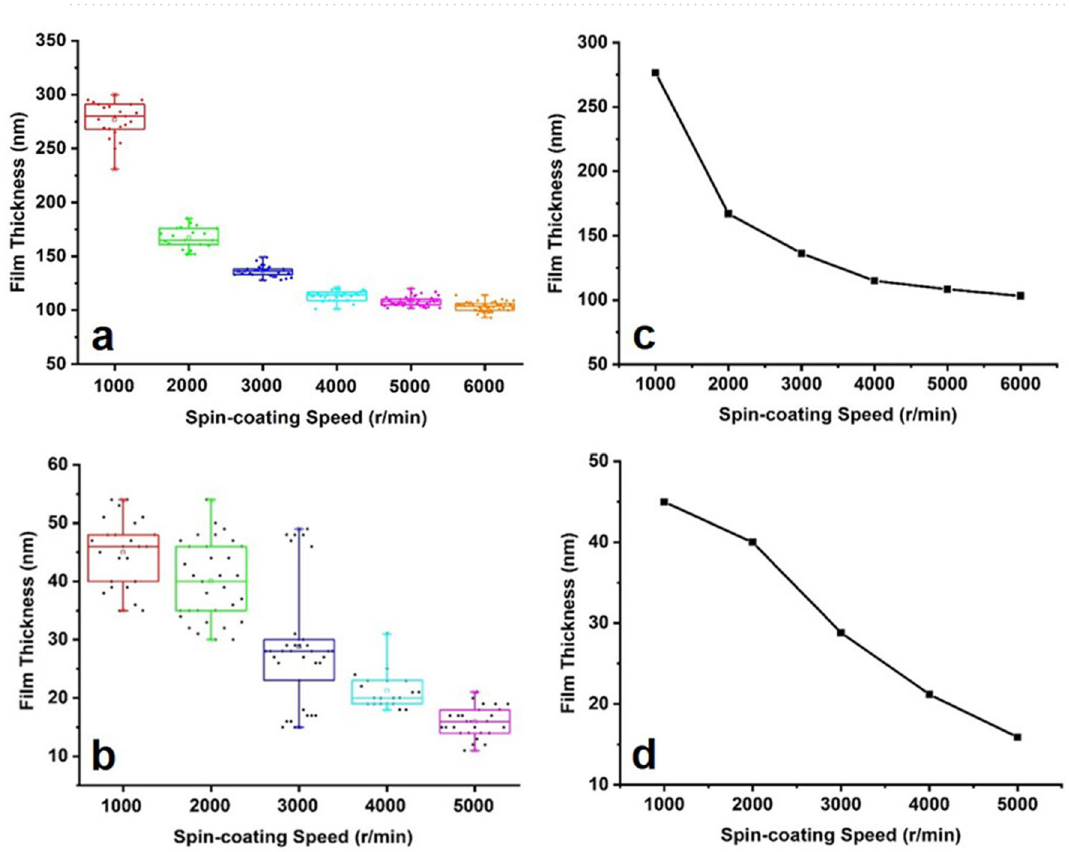
Figure 4. The box chart ( a , b ) and dot-line diagram ( c , d ) of PMMA and HSQ thickness at different spin- coating speeds. The area of the box in the box chart is 95% of all the data, and the horizontal line is the average